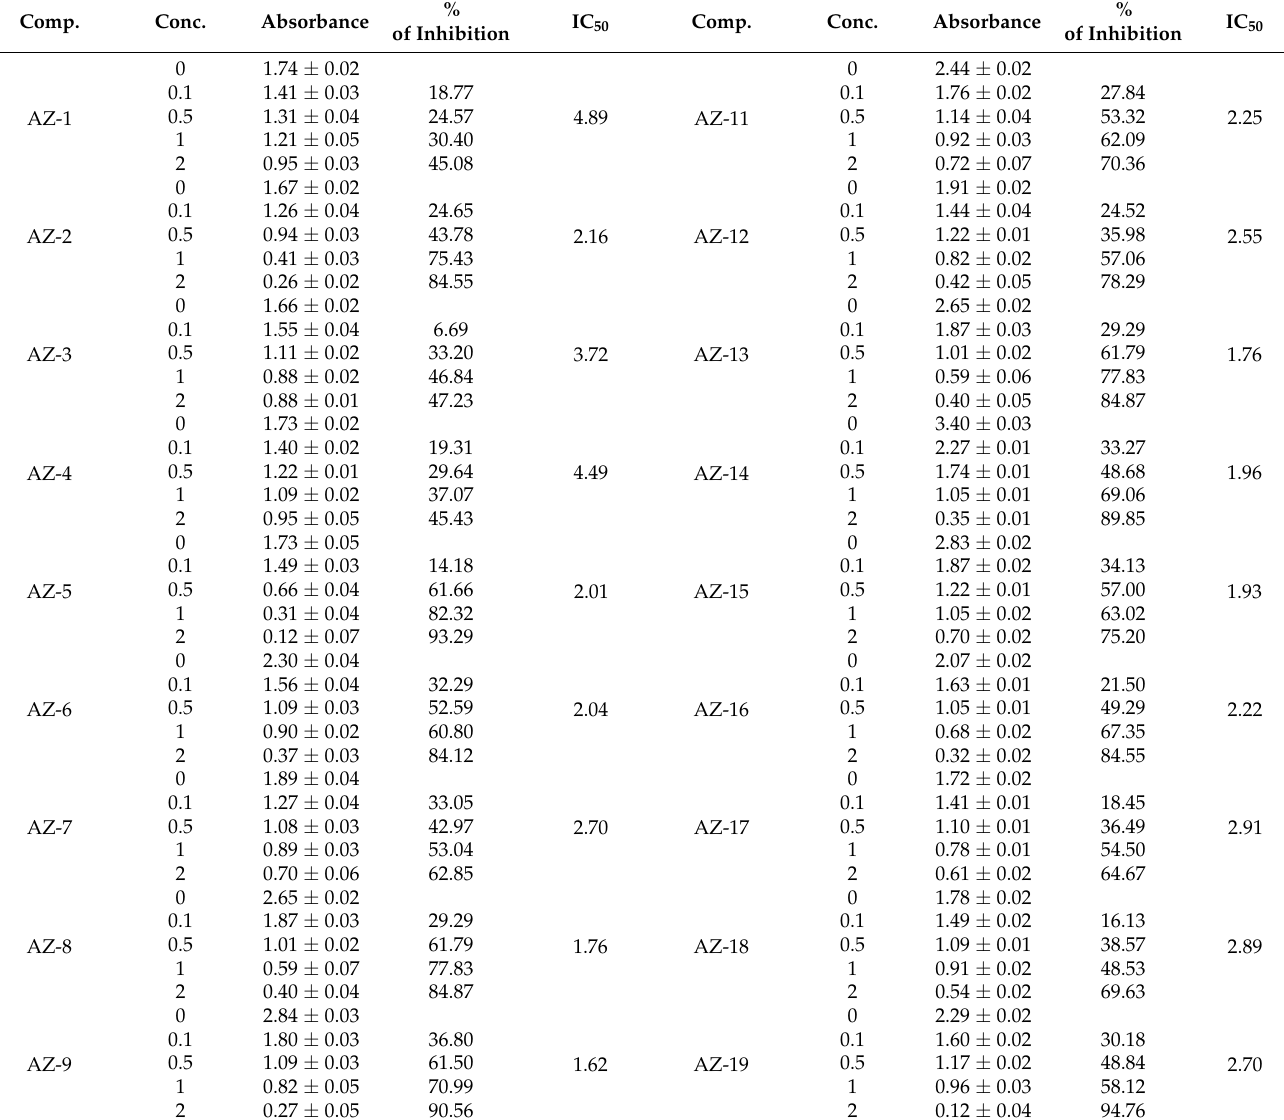
Table 4. In vitro cytotoxicity screening against MCF-7 of (substituted)-1,3,4-oxa/thia-diazol-2-yl)-3- chloro-4-(substituted) azetidin-2-one derivatives.